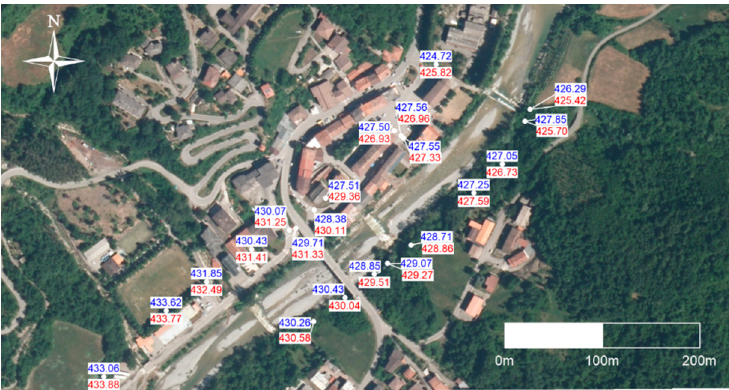
Figure 17. Observed (red) and computed (blue) maximum water elevations at Farini (m a.s.l.).